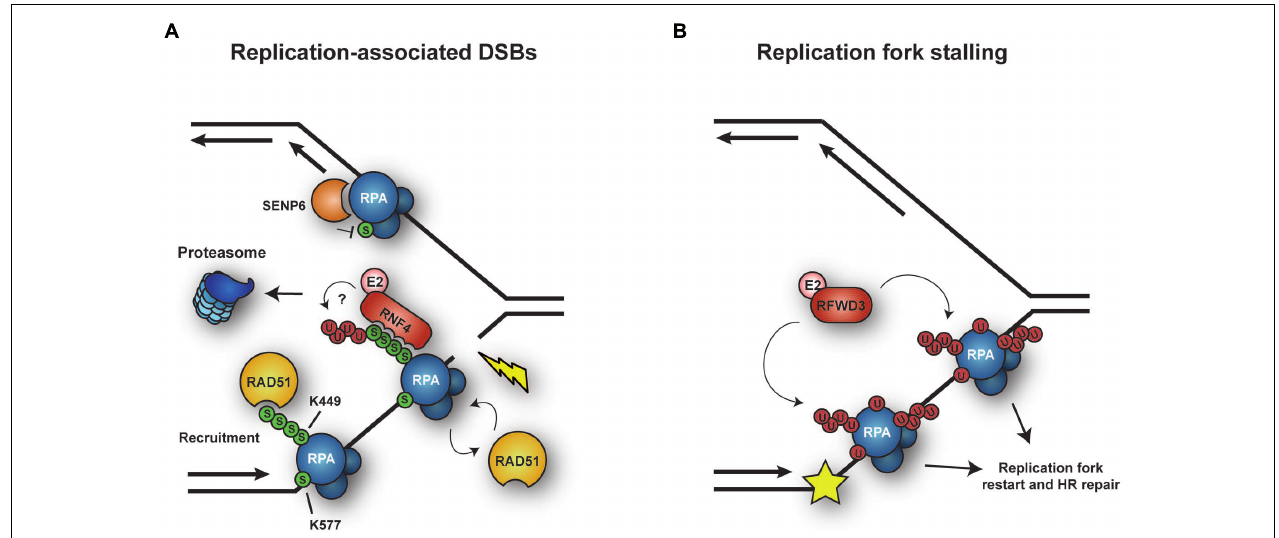
FIGURE 3 | Ubiquitylation and SUMOylation of RPA under conditions of replicative stress. (A) SUMOylation of RPA1 is counteracted by the protease SENP6 during unperturbed S phase. In response to replication-mediated DSBs, SENP6 dissociates, allowing SUMOylation of RPA1 in order to facilitate HR via recruitment of RAD51. In addition, RPA SUMO is recognized by the STUbL RNF4, which mediates proteasomal turnover of RPA1, thereby promoting exchange of RPA1 for RAD51. (B) Upon replication fork stalling, the ubiquitin E3 RFWD3 ubiquitylates RPA at multiple sites, thereby promoting replication fork restart and HR repair.